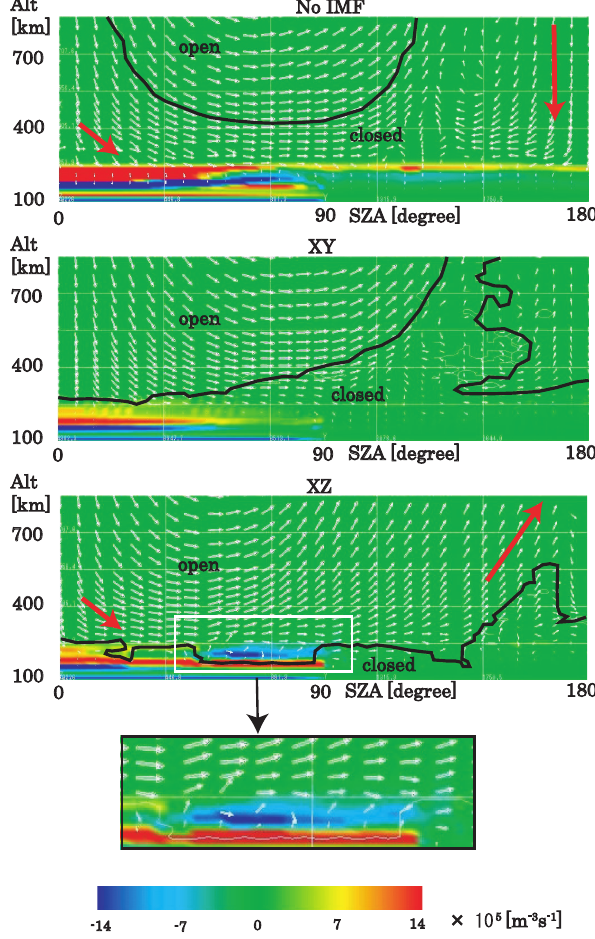
Fig. 10. Contour plots of the net O + production/loss obtained by 2 our MHD simulation. The arrows on the panels indicate velocity vectors. The top panel corresponds to the values in the case of no IMF. The middle panel corresponds to the values in the equatorial plane containing IMF. The bottom panel corresponds to the values in the meridian plane affected by magnetic tension. An enlargement of the white rectangular area in the bottom panel is shown. These are shown as functions of the solar zenith angle (horizontal axis) and the altitude (vertical axis). The label “open” indicates the region in which the open stream lines exist. The label “closed” indicates the region in which the closed stream lines exist. The red arrows in- dicate the characteristic flow direction. The flow direction on the nightside is planetward in the case without IMF, while the flow di- rection on the nightside is anti-planetward in the case with IMF. The flow direction on the dayside is downward in both cases; that is, the solar wind penetrates into the